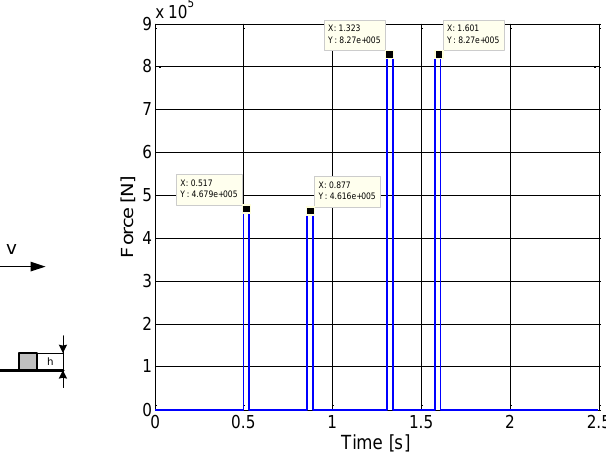
Fig. 4. The simplified model of truck. Fig. 5. Four rectangular pulse